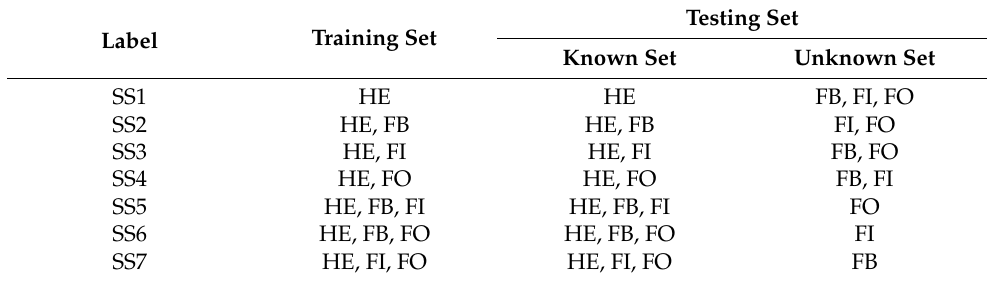
Table 2. Experimental set for each training and testing scenario for the rolling bearing